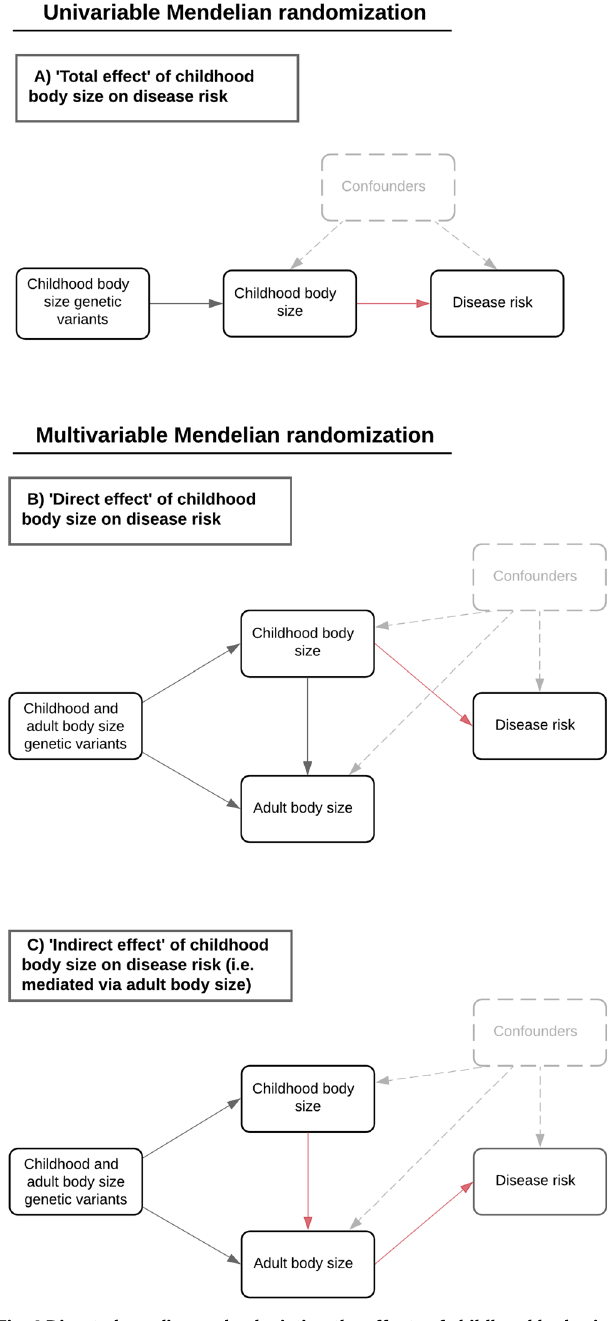
Fig. 1 Directed acyclic graphs depicting the effects of childhood body size on disease risk. Schematic representation of the analysis undertaken in this study using Mendelian randomisation (MR). A Using univariable MR to estimate the total effect of genetically predicted childhood body size on type 1 diabetes (T1D) risk without accounting for adulthood body